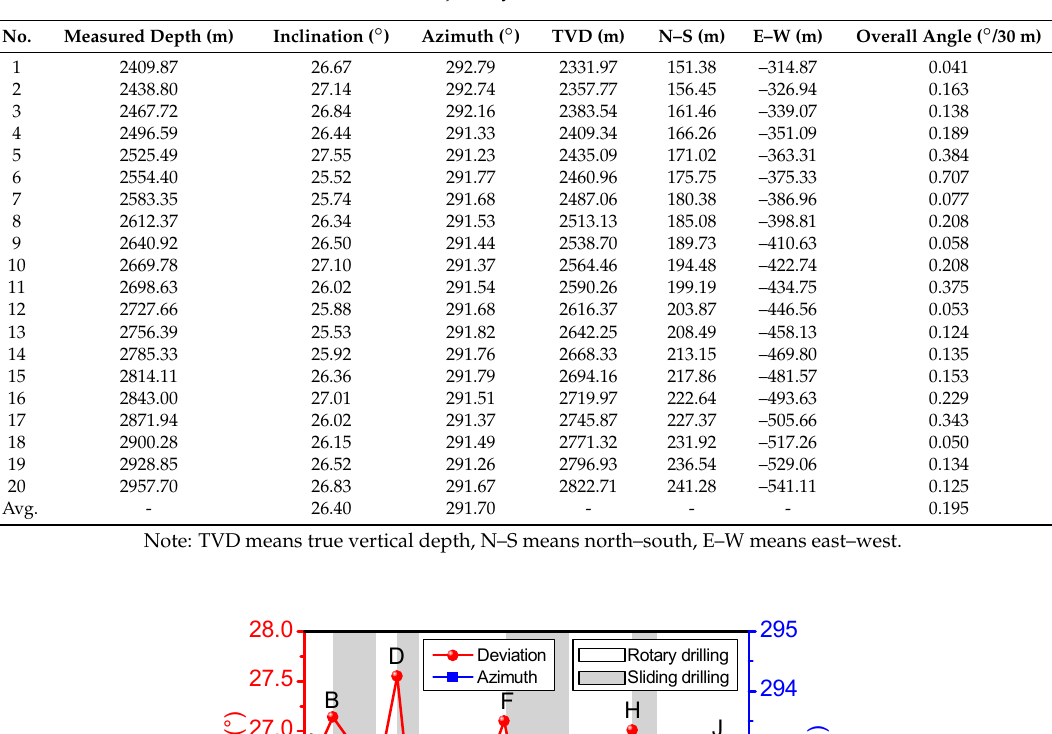
Figure 12. The trajectory of well B, where the blue points represent the survey data, the red points represent the subpoint of the survey data in three coordinate planes, the red full line represents the real drilling trajectory, and the blue dotted lines represent the subline of the real drilling trajectory in three coordinate planes. Table 3. The trajectory of test interval in well B.